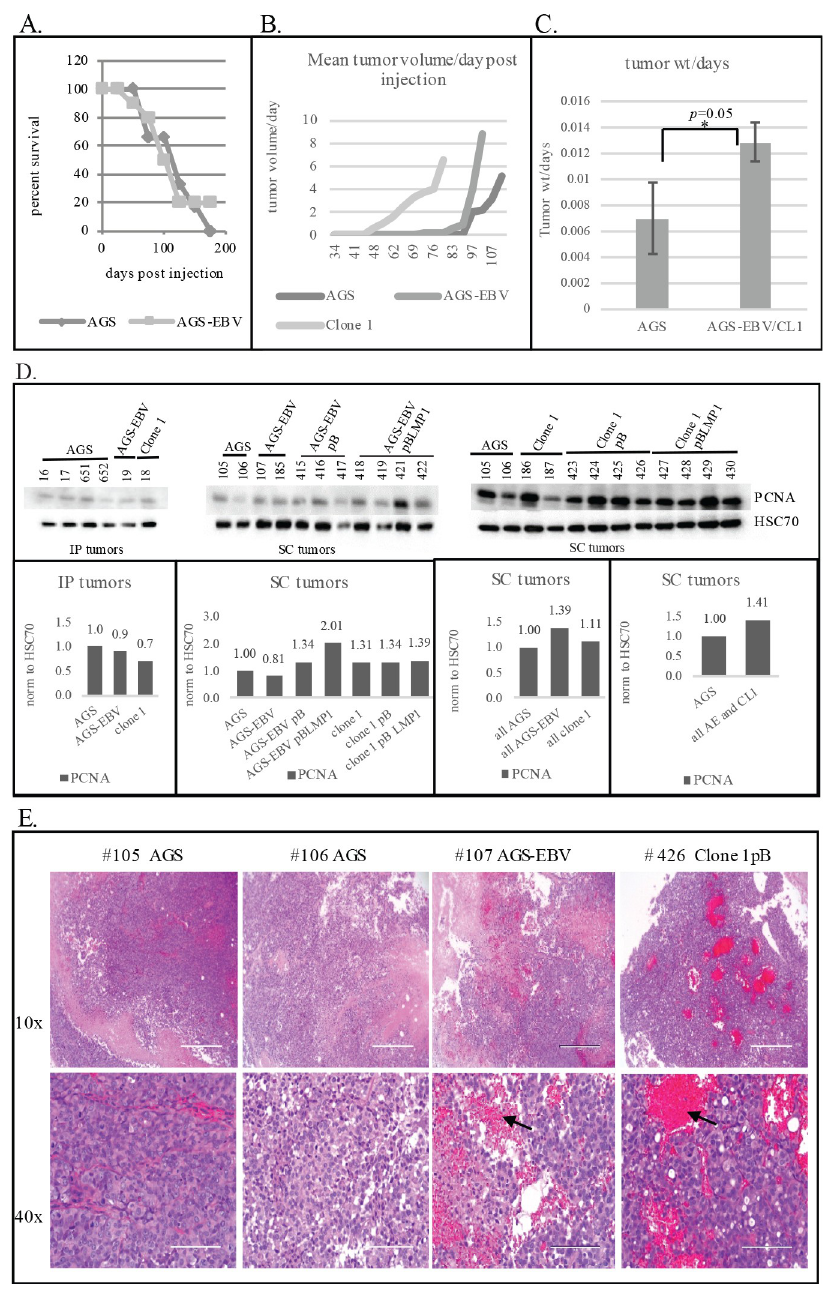
Fig 1. Survival, tumor growth, and proliferation rates of EBV - AGS tumors and EBV + AGS-EBV/Clone 1 tumors that develop in mice. (A) Kaplan-Meier survival plot of AGS injected mice and the AGS-EBV/Clone 1 injected mice as a function of days post injection subcutaneously (SC) or intraperitoneally (IP). (B) Average growth rate of the tumors post subcutaneous injection (SC) of the cell lines measured in tumor volume and days post injection. Graph of mean tumor volume at days post subcutaneous injection for each of the three cell lines, AGS; AGS-EBV and pB derivatives; and Clone1and pB derivatives. (C) Graph of mean tumor weight at harvest/days post injection at harvest of the AGS tumors (IP and SC) and the AGS-EBV and Clone1 and pB derivatives (IP and SC). (D) Western blot detection of PCNA in the IP and SC tumors that develop following injection of the AGS, AGS-EBV, and Clone1 cell lines and pB derivatives and quantification of the PCNA normalized to HSC70 as a loading control using the Image Lab software (Biorad). (E) Haemotoxylin and eosin staining of representative AGS, AGS-EBV, and Clone 1 tumors. Arrows denote presence of red blood